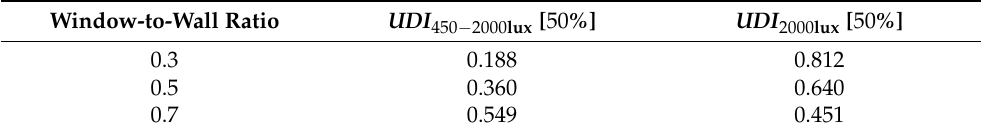
Table 8. Weights of UDI 450 − 2000lux [ 50% ] and UDI 2000lux [50%] under different window-to-wall ratios for the small south-facing office